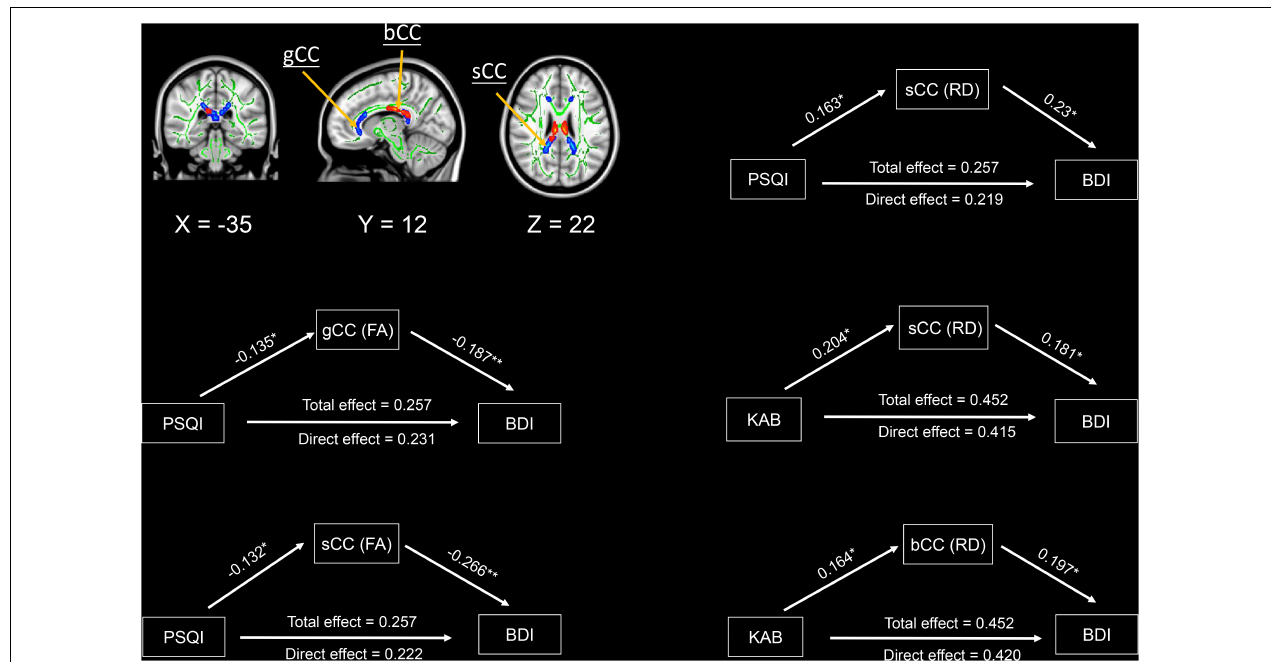
FIGURE 4 | Mediation effects among sleep quality, current stress levels, brain white matter microstructures, and depressive symptomatology. Significant areas were extracted from above voxel-wise correlations analysis, which were significantly correlated with depression and stress. Green/Red colors indicate the significant negative/positive correlations between diffusion metrics and depression/stress. Significant level: * p < 0.05, ** p < 0.005. Abbreviations: FA, fractional anisotropy; RD, radial diffusivity; PSQI, Pittsburgh sleep quality index; BDI, Beck depression inventory; KAB, Kurzfragebogen zur Aktuellen Beanspruchung; sCC, splenium